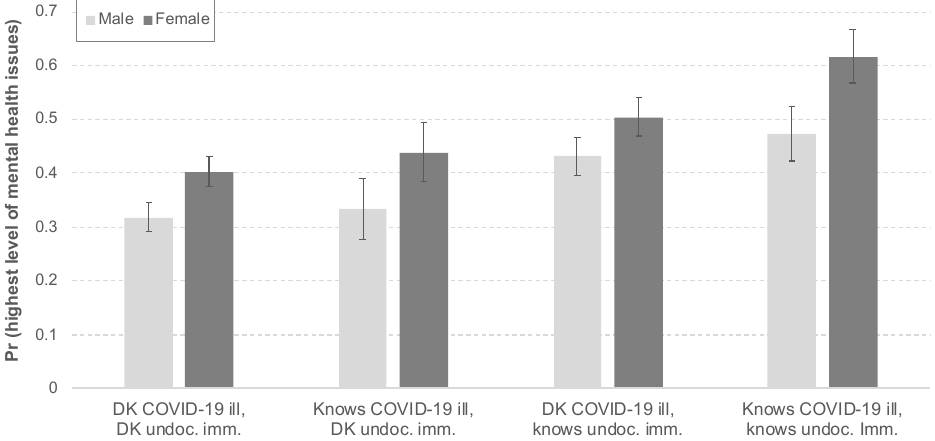
Figure 3. Predicted probabilities of reporting the highest level of mental health issues (three-way interaction among gender, knowing someone with COVID-19, and knowing undocumented immigrant). Source: Authors’ analysis using the SOMOS COVID-19 Crisis National Latino Survey (2020).